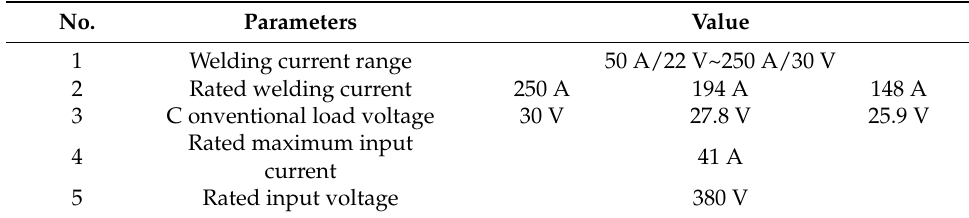
Table 5. Typical equipment parameters.